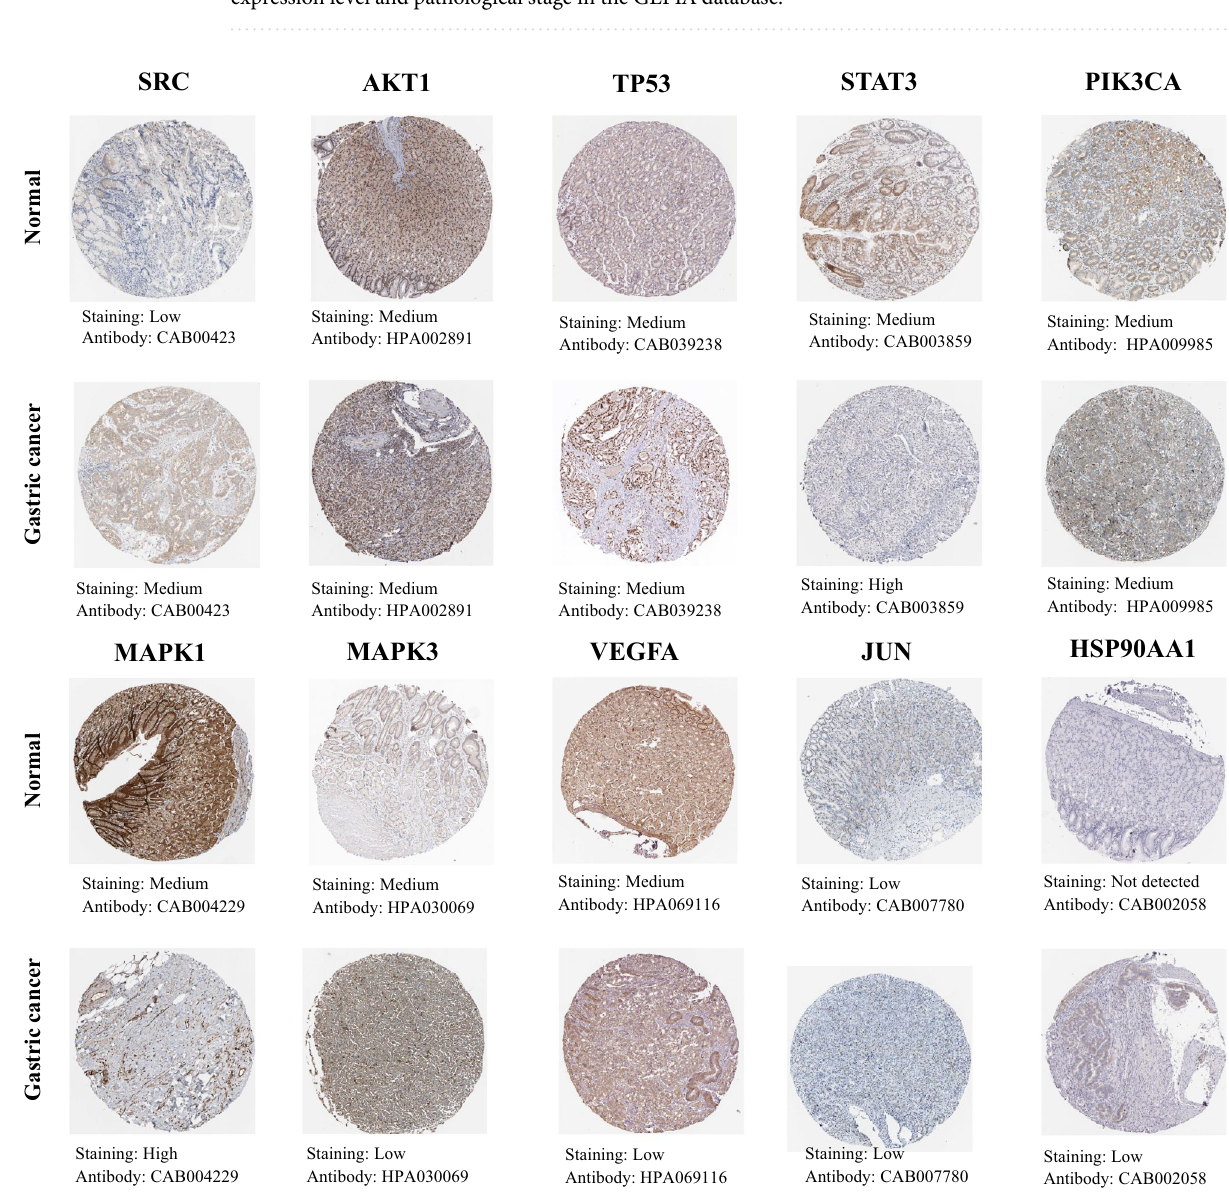
Figure 8. Immunohistochemical images of hub gene protein expression levels in the HPA